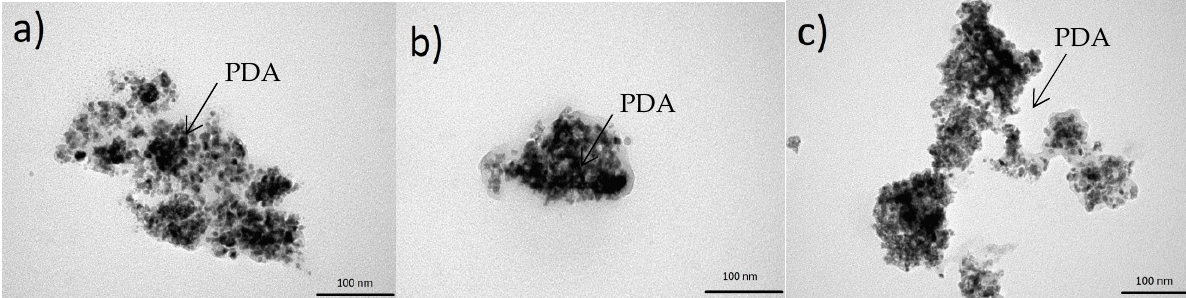
Figure 5. TEM images of ( a ) PDA10@CeO 2 , ( b ) PDA25@CeO 2 and ( c ) PDA50@CeO 2 .